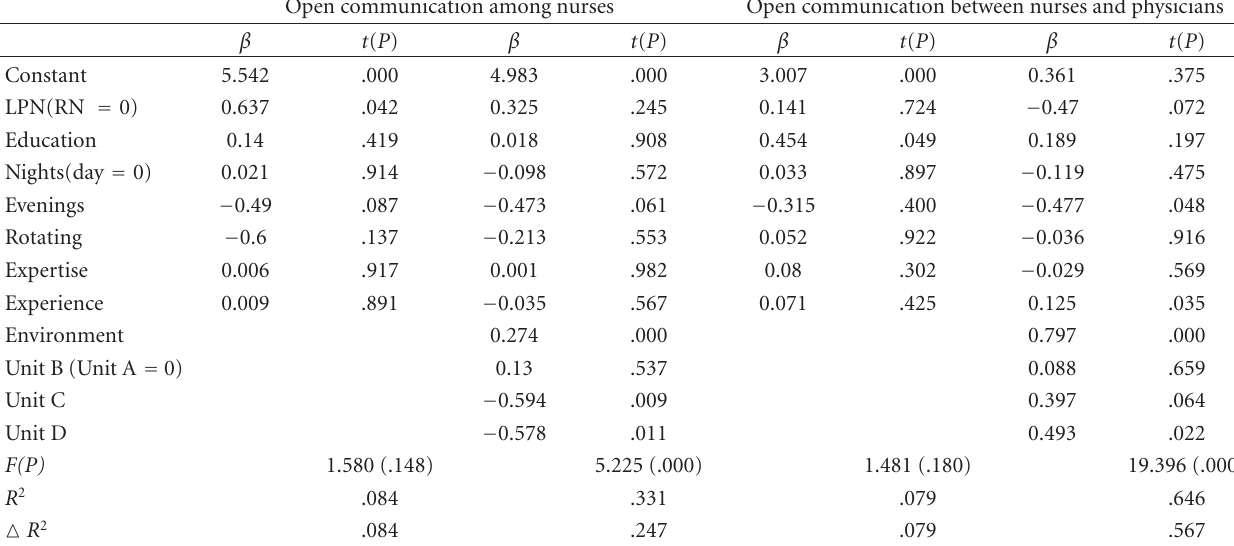
Table 3: Hierarchical multiple regression analysis predicting openness of communication ( n =